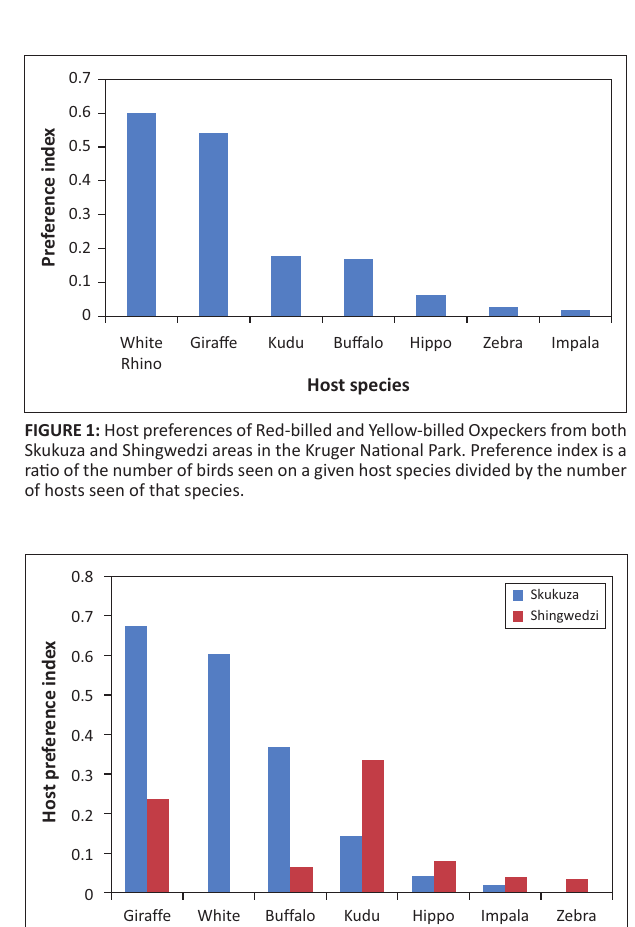
FIGURE 2: A comparison of host preference indices for Red-billed Oxpeckers in the Skukuza and Shingwedzi areas of the Kruger National Park.